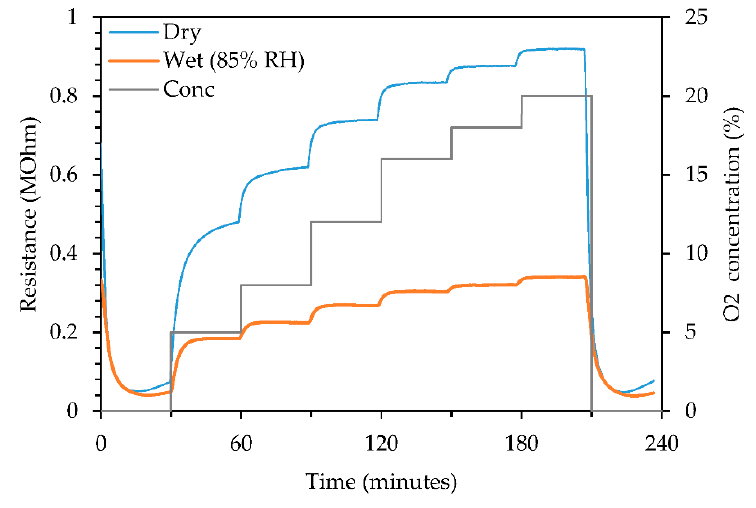
Figure 2. Sensor dynamic responses to various O 2 concentration at 350 °C.